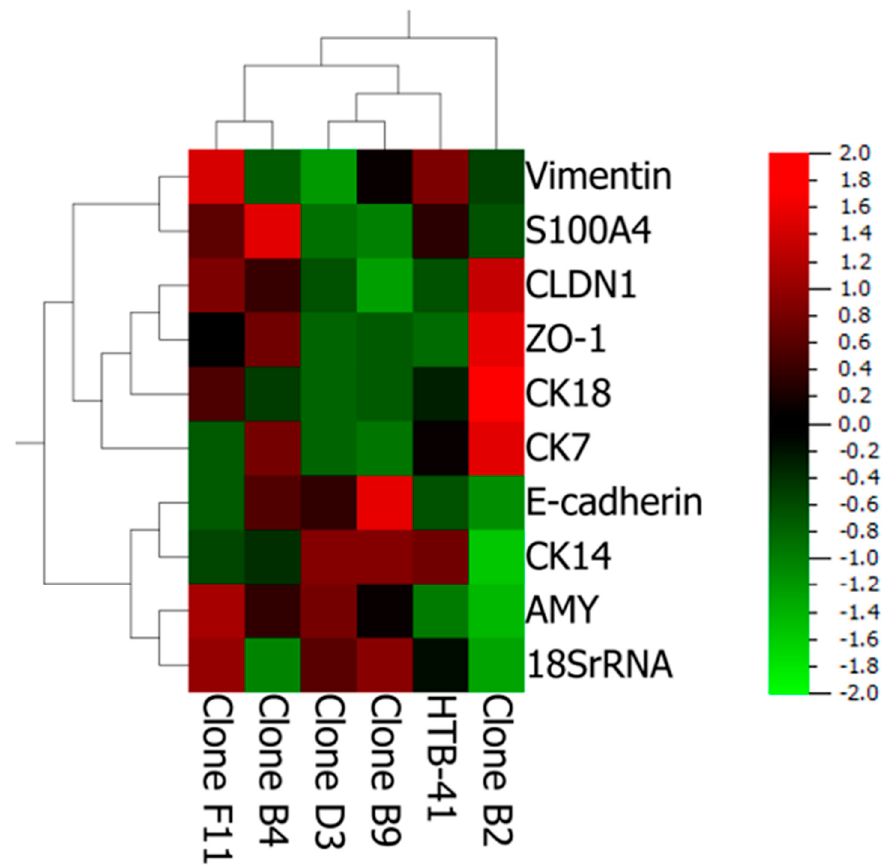
Figure 3. Heatmap showing qPCR results as x-fold expression values from clone B2, B4, B9, D3, and F11 normalized against expression values of the parental HTB-41 with 18SrRNA as endogenous control. Mean values of three independent experiments ( n = 5) are displayed using a color scale, with 2 (red) indicating a high expression and − 2 (green) indicating a low expression value. Mean ± SEM values and statistical analysis are shown in Table S3. AMY: α -amylase, CK: cytokeratin, CLDN1: claudin-1, E-cad: E-cadherin, Vim: vimentin, S100A4: S100 calcium-binding protein A4, ZO-1: Zonula occludens-1 .